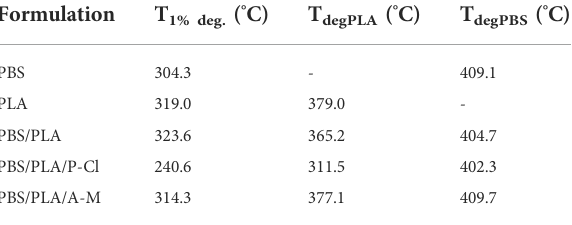
TABLE 4 Degradation temperatures of PLA and PBS phases and degradation temperature for 1% wt. loss from thermogravimetric